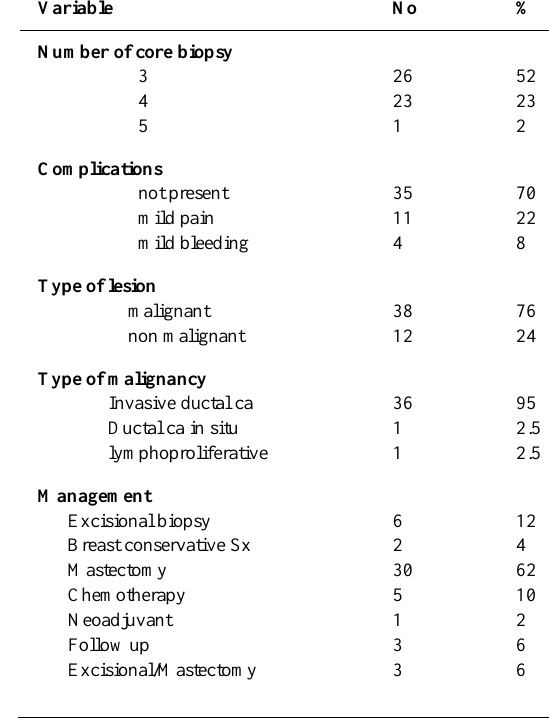
Table 2 : Core needle biopsy characteristics